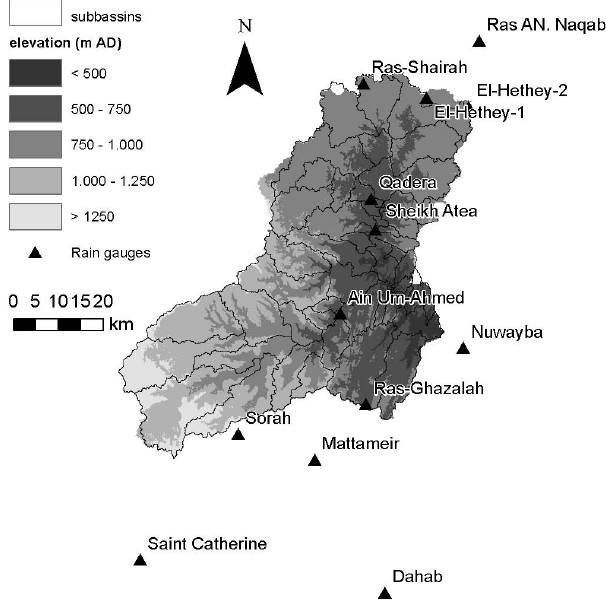
Fig. 3. Wadi Watir: topography, subbasins and rain